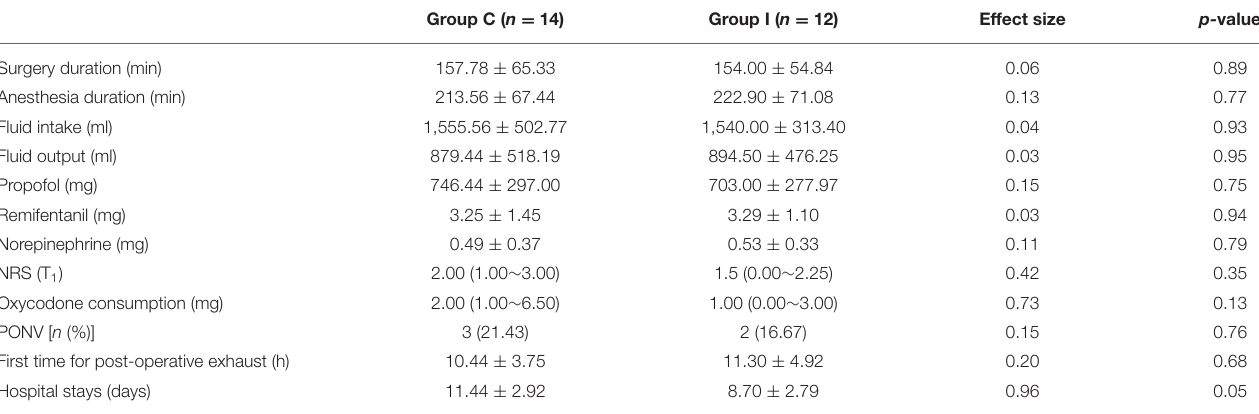
TABLE 7 | Secondary